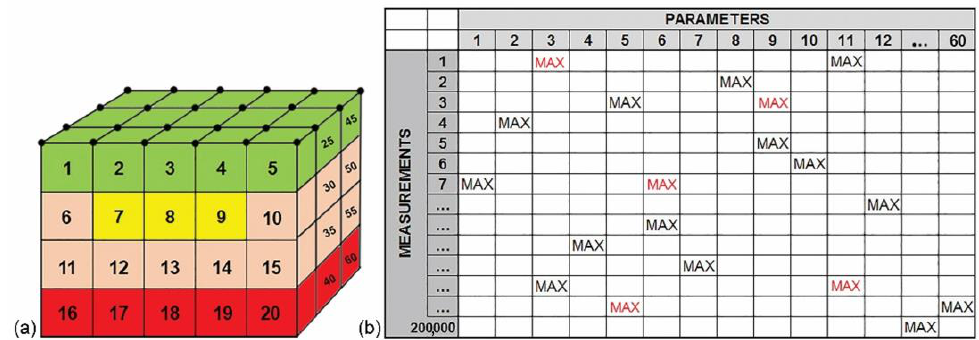
Figure 1. ( a ) Simplified 3-D model with 60 parameters, where the sensitivity value of each parameter is decreasing in larger distances from the surface electrodes (black dots). ( b ) Representation of the Jacobian matrix where the higher sensitivity absolute values (rows) are located for the 60 parameters of the model (columns) (detailed description in the text).